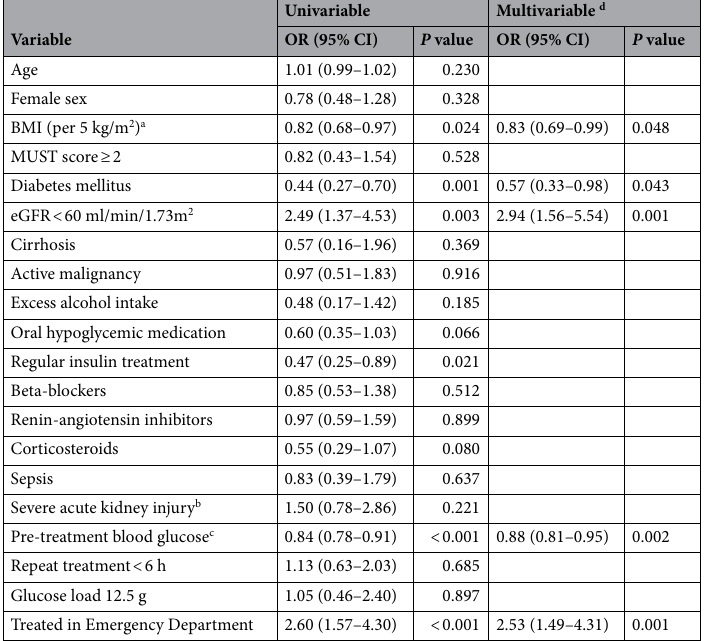
Table 3. Logistic regression analysis. a Missing observations in BMI (n = 11). b Stage 3 AKI and excluding long-term dialysis patients (n = 395). c Missing observations in pre-treatment blood glucose (n = 22). d Multiple imputation using chained equations (m = 20) for missing